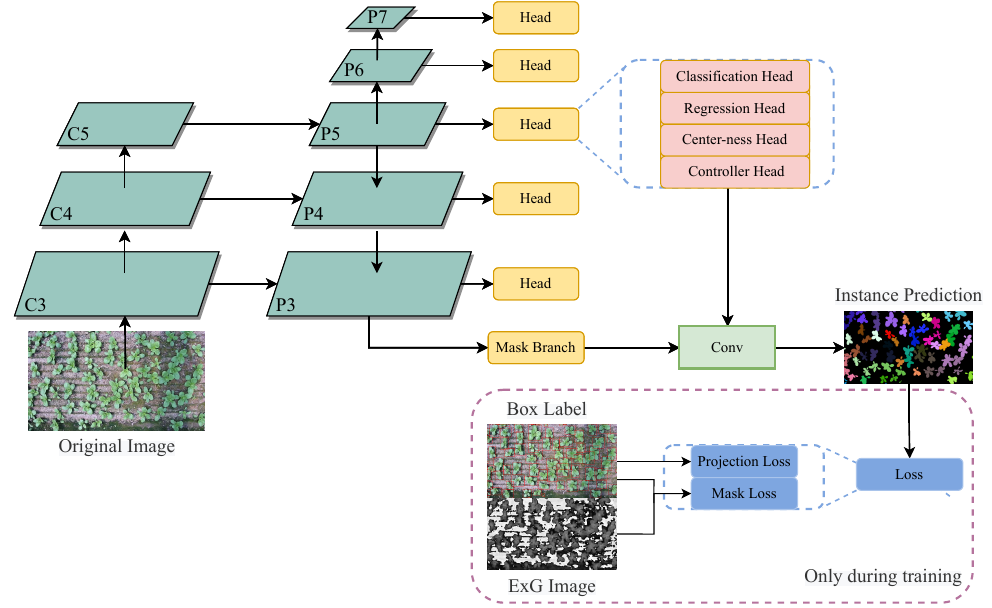
Figure 3. Schematic diagram of leafy greens segmentation neural network.